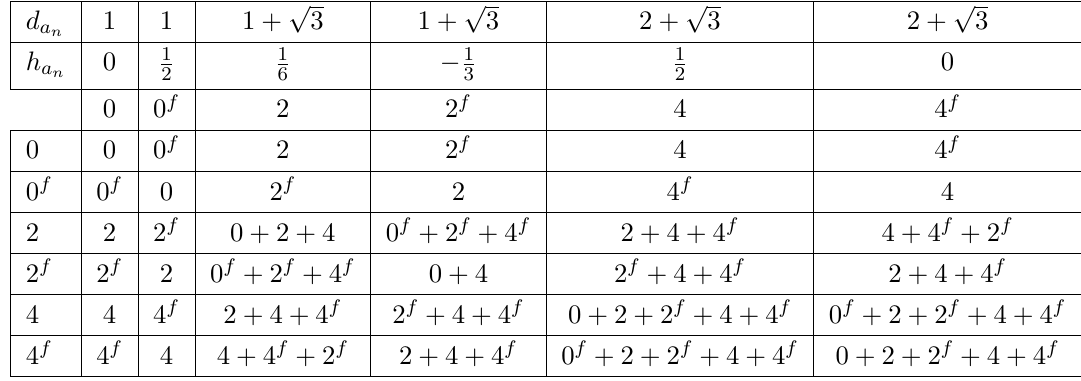
, where a 0 and a f are SU(2) 10 0